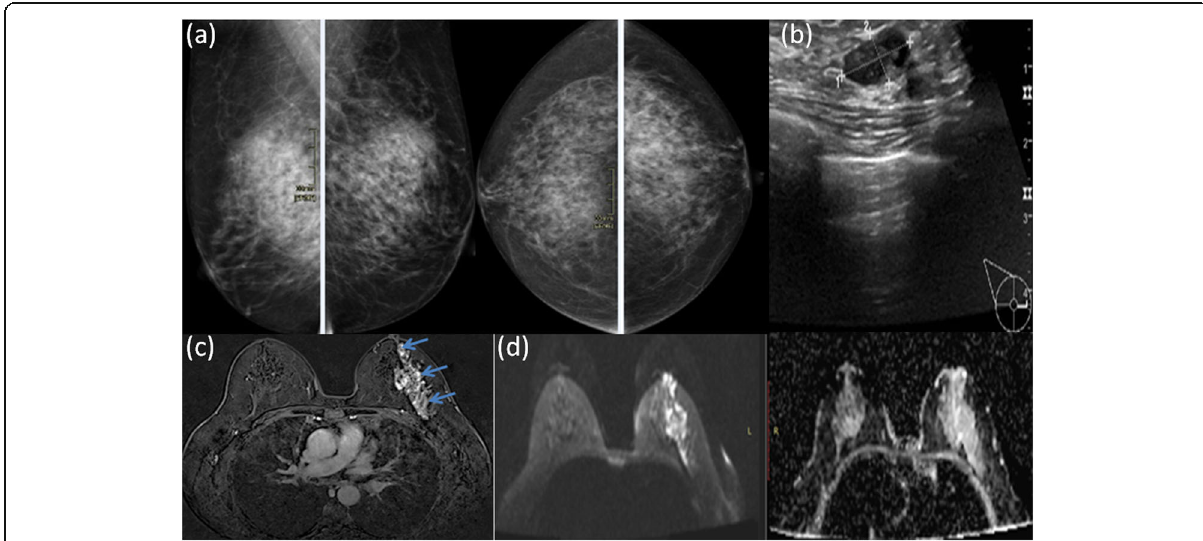
Fig. 4 A case of DCIS with microinvasive carcinoma (T3N1). a Mammography revealed no spiculated mass lesions or microcalcifications. b Complementary US revealed upper central and outer quadrant benign looking lesions; however, biopsy was recommended. c DCE-MRI breast revealed left breast segmental heterogeneous area of pathological non-mass enhancement seen partially involving both the upper and lower outer quadrants extending from 1 to 5 o ’ clock position. The pathological enhancement is seen extending to reach the nipple. d Facilitated diffusion was noted on DWI-MRI. In this case, DCE-MRI revealed the same tumor size stage correlating to the pathological specimen result, while SM and DWI-MRI missed the lesion